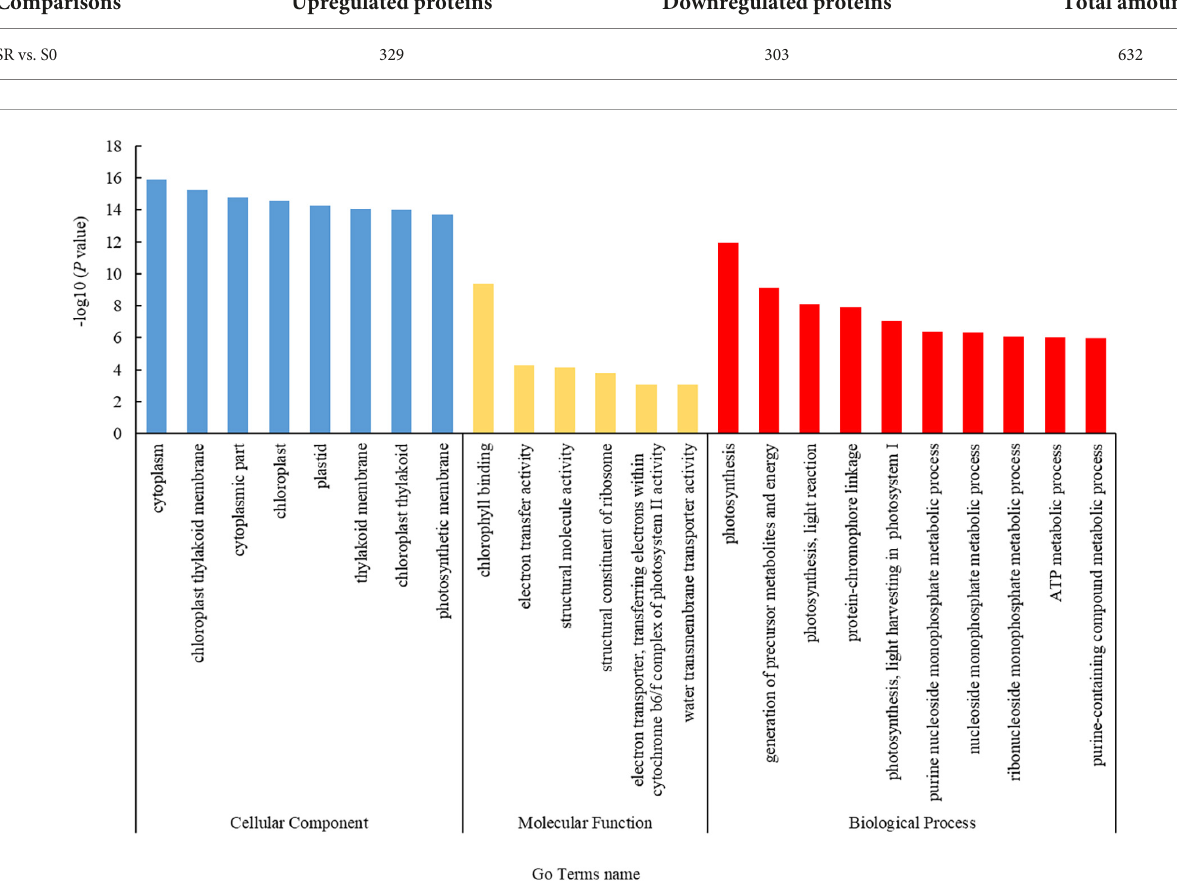
FIGURE2 Gene Ontology (GO) annotation statistics of the differentially expressed proteins (DEPs). The GO annotations included cellular component, molecular function, and biological process terms, which are color coded as blue, yellow, and red, respectively. The ordinate indicates the negative common logarithm of the P -value derived from enrichment analysis, i.e., –log 10 P -value, for each